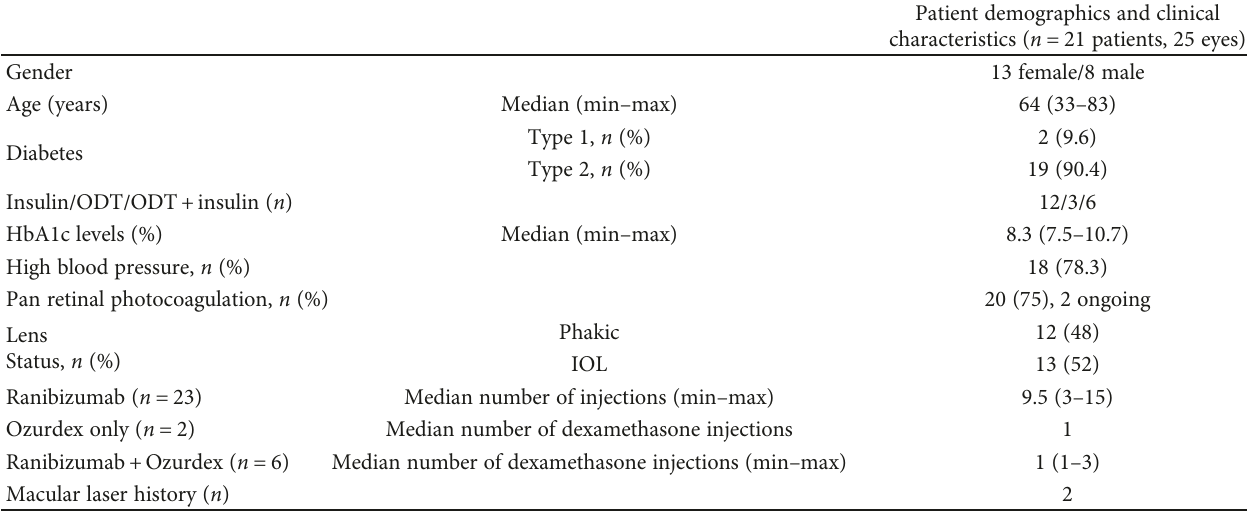
Table 1: Patient baseline demographics and clinical characteristics.